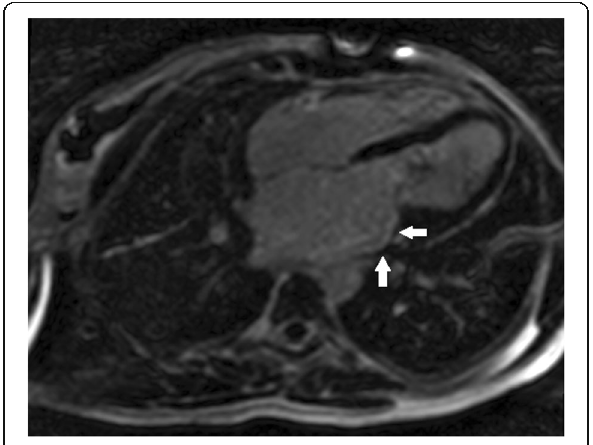
Fig. 2 DE-MRI showing mild atrial fibrosis (involves a part of the posterior wall of the left atrium,